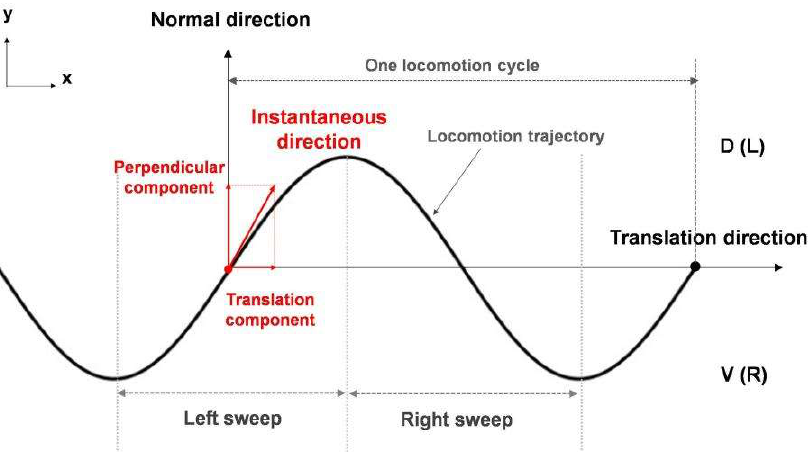
Figure 2. Definitions of kinematics-related terms.